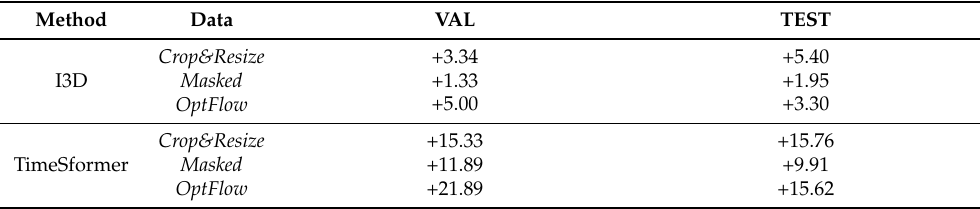
Table 5. Difference in accuracy between the original models and the transferred models (models with the AUTSL pretraining) on